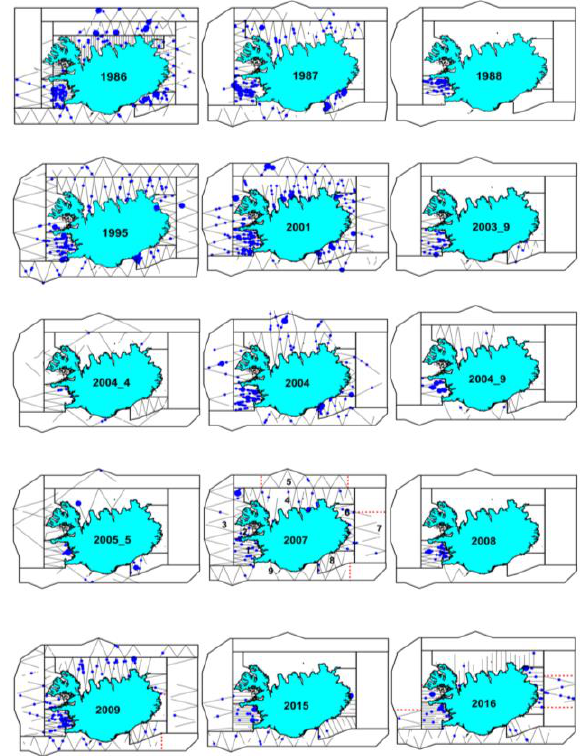
Figure 4. Realized survey effort and sightings of common minke whales by survey. Survey month is appended to year (numerical) if not June or July. Symbol size varies with group size from 1 to 3. Post-stratification borders are shown as red dotted lines.